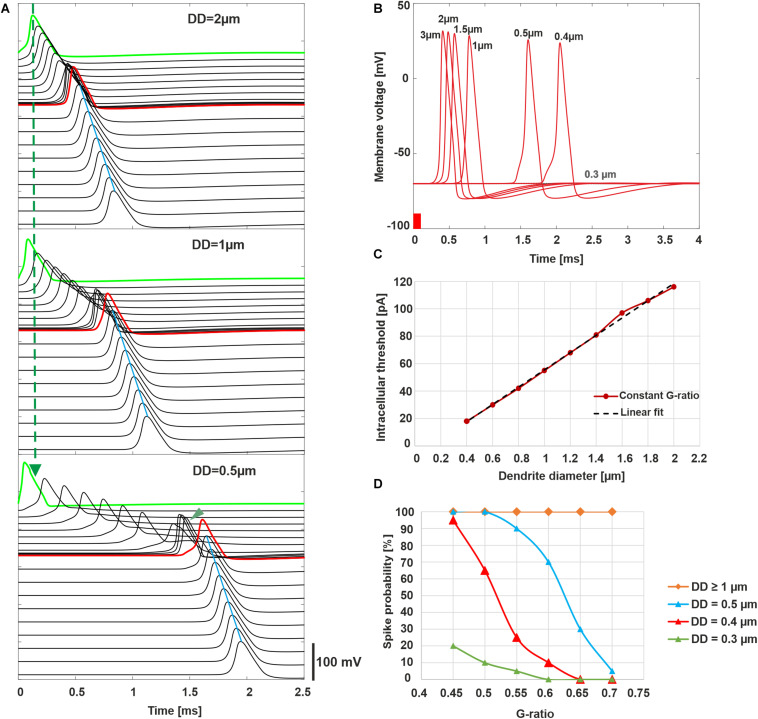
Intracellular ANF stimulation simulating synaptic excitation. (A) Excitation and AP conduction along the ANF (300 pA, 100 μs). AP is initiated in the first compartment (green; note the quicker excitation when DD is reduced marked by dashed vertical line; presomatic compartments are marked with arrowhead for DD = 0.5 μm and show slow conduction velocity for thin fibers). Conducted APs are shown for all active compartments with a vertical shift indicating the compartment’s location. The arrival time of the AP in the soma (red) increases when DD decreases. Axon’s conduction velocity (marked by blue line at AP peaks) outmatches all dendritic cases as a consequence of the larger axon diameter (4 μm). (B) Membrane voltage in the soma for varied DD demonstrates increased latency when DD is reduced; no AP for DD = 0.3 μm. (C) Synaptic threshold current for AP conduction as a function of DD (red) and linear fit (black dashed line). (D) Probability of spike conduction across the soma as a function of G-ratio for various DD. In panels A–C, G-ratio = 0.625 (mean value of the control). (A) and (B) were calculated without noise, (C,D) with the stochastic model that included current fluctuations in the active membrane.